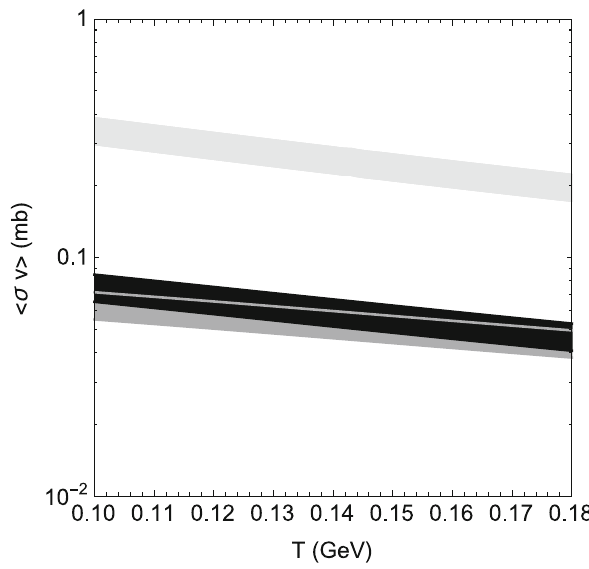
Fig. 5 Thermally averaged cross section to the processes π Z b → ¯ BB (medium shaded region), π Z b → ¯ B ∗ B (dark shaded region) and π Z → ¯ B ∗ B ∗ (light shaded region), as a function of temperature b